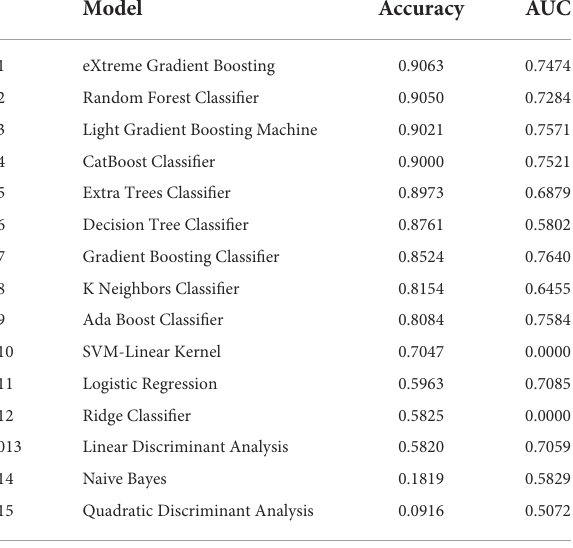
TABLE 2 Performance of different